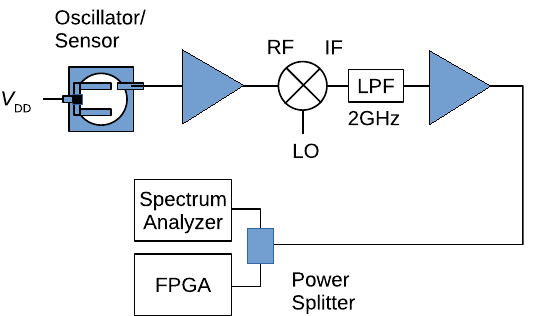
Figure 15. Experimental setup for noise floor measurement and sound